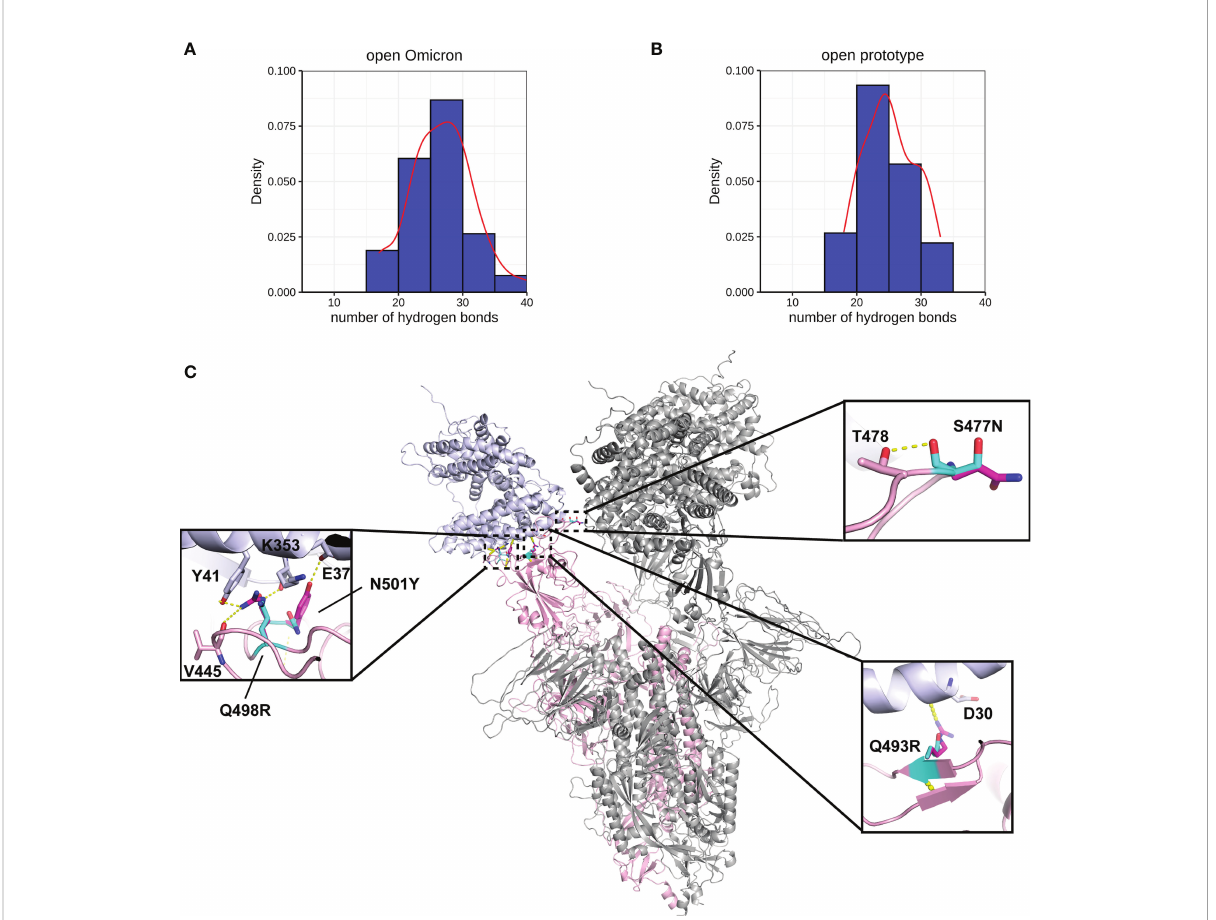
FIGURE 4 Interactions between Spike and ACE2. Hydrogen bond interaction distribution between residues in Spike (residues 332-527) and ACE2 proteins during 20 ns of triplicate MD simulations in (A) open Omicron and (B) open prototype variants are shown in blue histogram with its smoothed density line shown in red. These both represent RBD-up conformation of Omicron and Prototype Spike proteins. Density on y axis refers to the Kernel density, the image depicts the probability density function of the variable. The Spike protein was presented in ribbon with three RBD all binding to ACE2 (C) . Four mutations in the receptor binding interface were zoom-in. Both prototype (cyan) and Omicron residues (magenta) were shown in sticks with the Carbon atoms on Spike-ACE2 complex (pink-blue). Hydrogen bond was shown in yellow dash